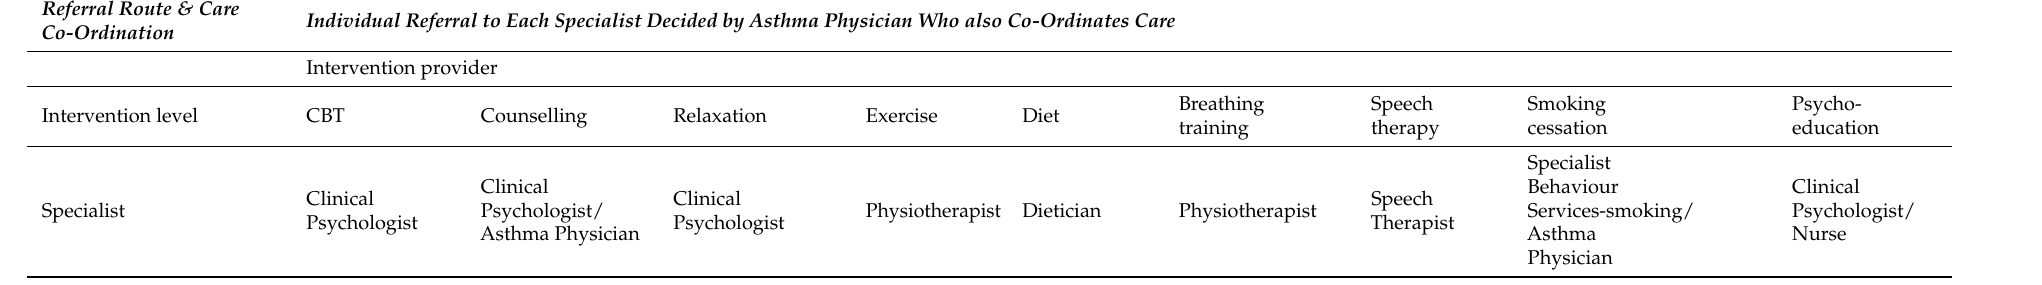
Table 1. Current model of non-pharmacological intervention provision for treatable traits in patients living with Difficult Breathing Syndrome.